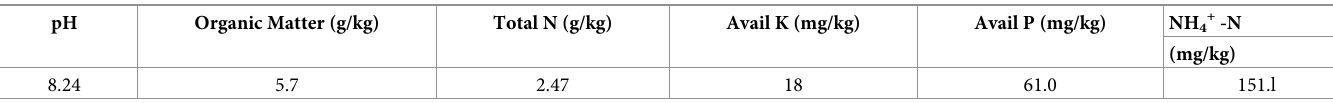
Table 1. Initial soil nutrient status before the